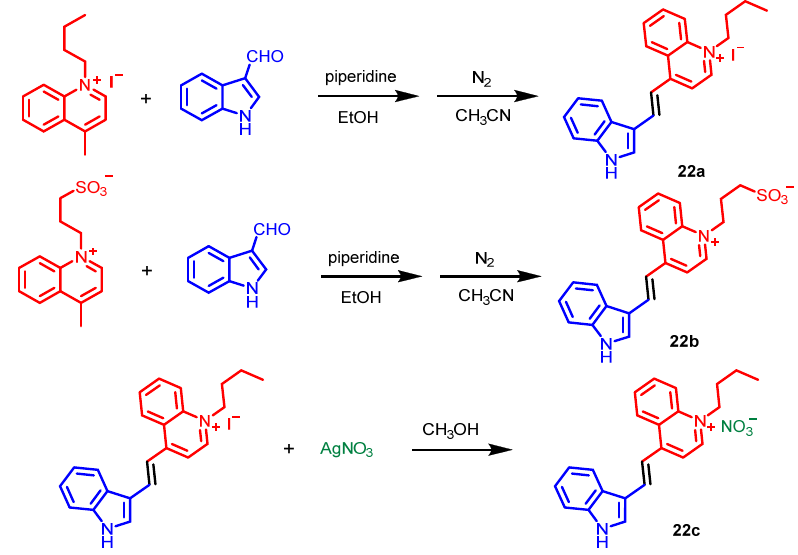
Scheme 18. Synthesis of quinolineindole-based derivatives 22a – c .